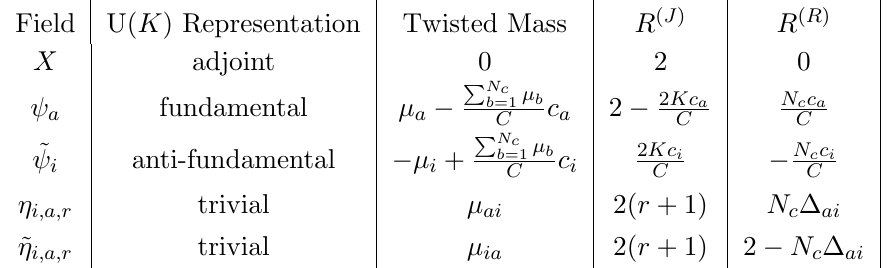
Table 3 . The spectrum on the worldsheet for strings satisfying